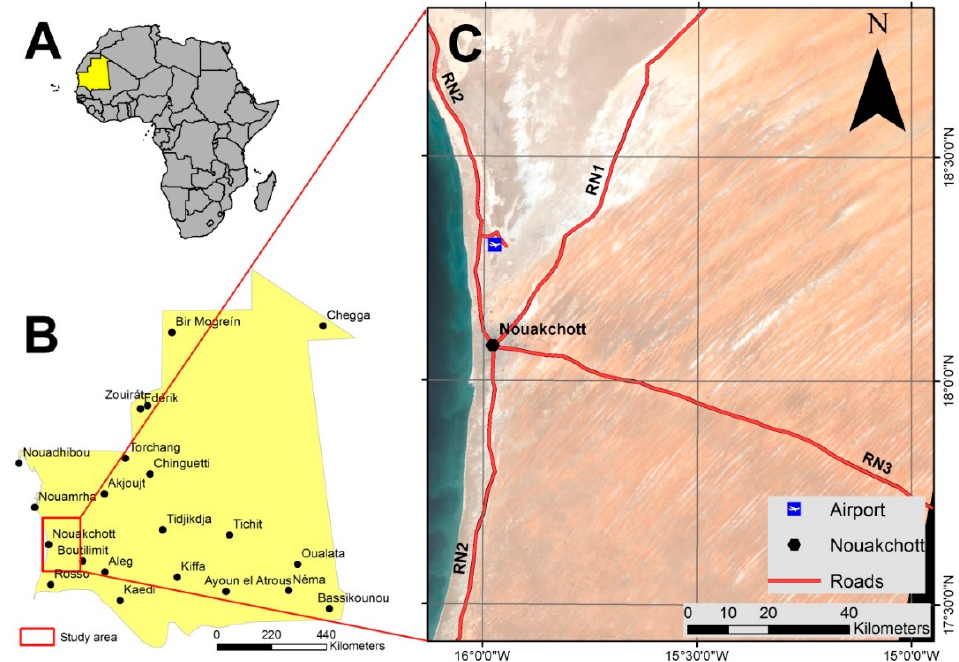
Figure 1. ( A ) Location of Mauritania within the African continent, ( B ) principal population sites and ( C ) location of the study area in Mauritania.